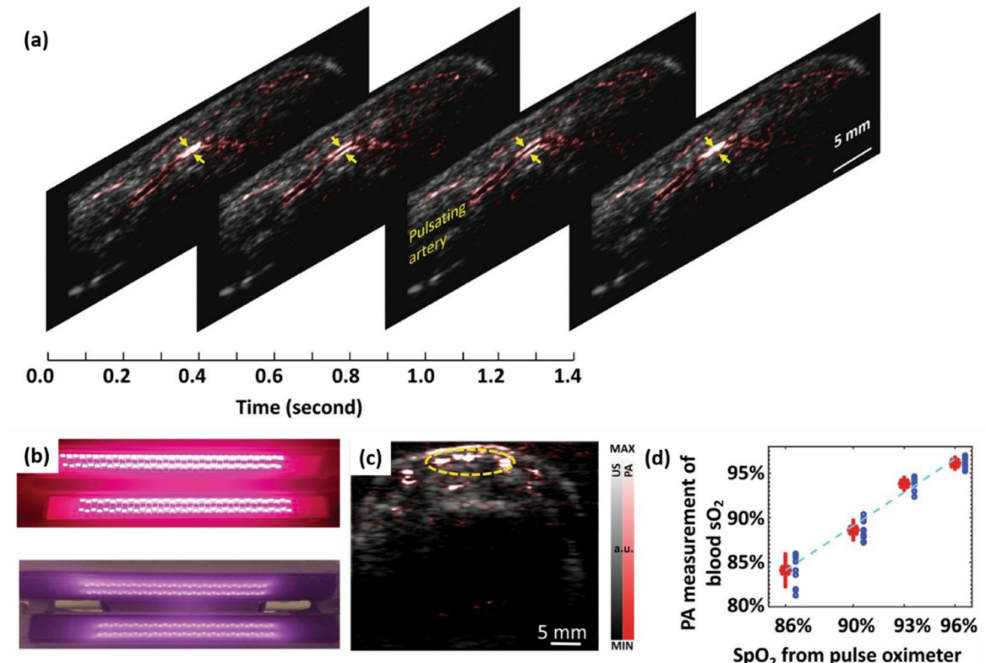
Figure 11. ( a ) Four frames from a PA imaging video (index finger, longitudinal section) presenting the pulsation of an artery marked by the arrows. ( b ) Photo of a pair of dual-wavelength LED bars that emits 690-nm and 850-nm light alternatively. ( c ) PA-US combined image showing a cross-section of the vasculature in a human finger. ( d ) Correlation between the LED-PAI-based blood sO2 in the finger and the SpO2 readouts from a pulse oximeter. Reprinted from Ref.